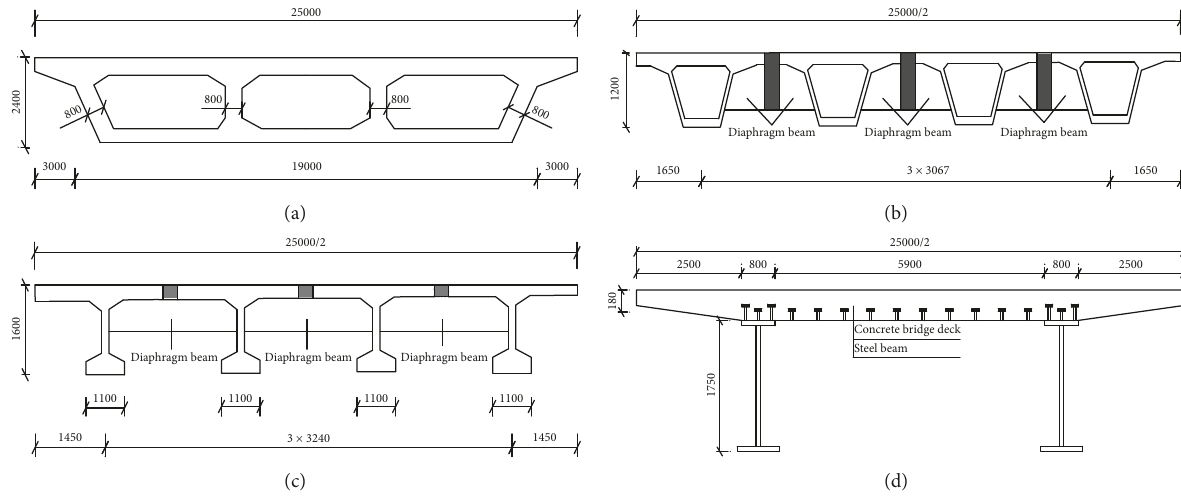
Figure 1: Typical beam cross sections of (a) MCBG, (b) MBBG, (c) CIGB, and (d) SIGB (unit: mm).